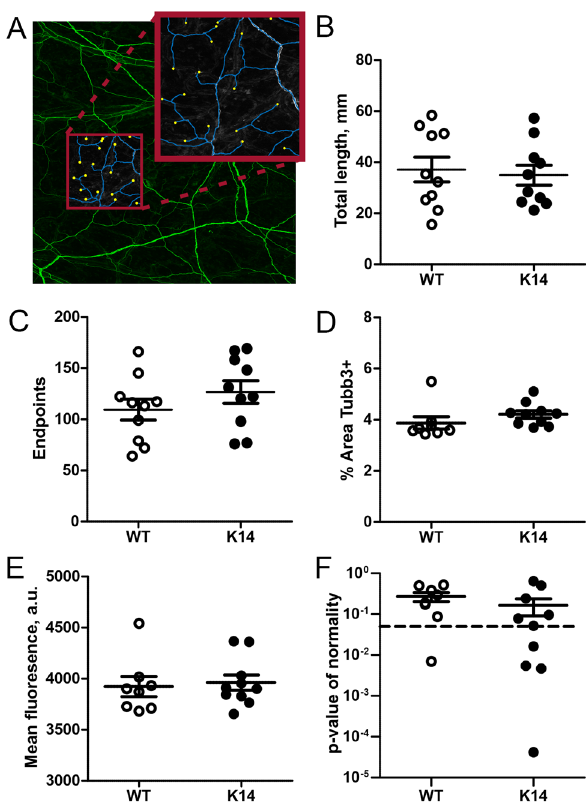
Figure 7. Segmentation analysis of meningeal innervation. ( A ) A representative image of meninges stained for β-tubulin III (green), segmented for morphological analyses. Blue lines represent axons, and yellow filled circles represent endpoints (i.e., CGRP-releasing trigeminal fiber terminal endings). ( B ) No differences in the total innervation length were observed between the two genotypes ( p = 0.73 by unpaired Student’s t-test; n = 10/ experimental group). ( C ) Similarly, the number of trigeminal fiber terminal endings was comparable in WT and K14 meninges ( p = 0.26). ( D – F ) Analysis of the region-specific meningeal innervation patterns. No genotype differences were observed in the percentage of Tubb3 + area ( p = 0.22, WT n = 8; K14 n = 10) ( D ), the intensity of Tubb3 fluorescence signal ( p = 0.75) ( E ), and in the Gaussian distribution of nerves ( p = 0.31). Data are presented as mean ±